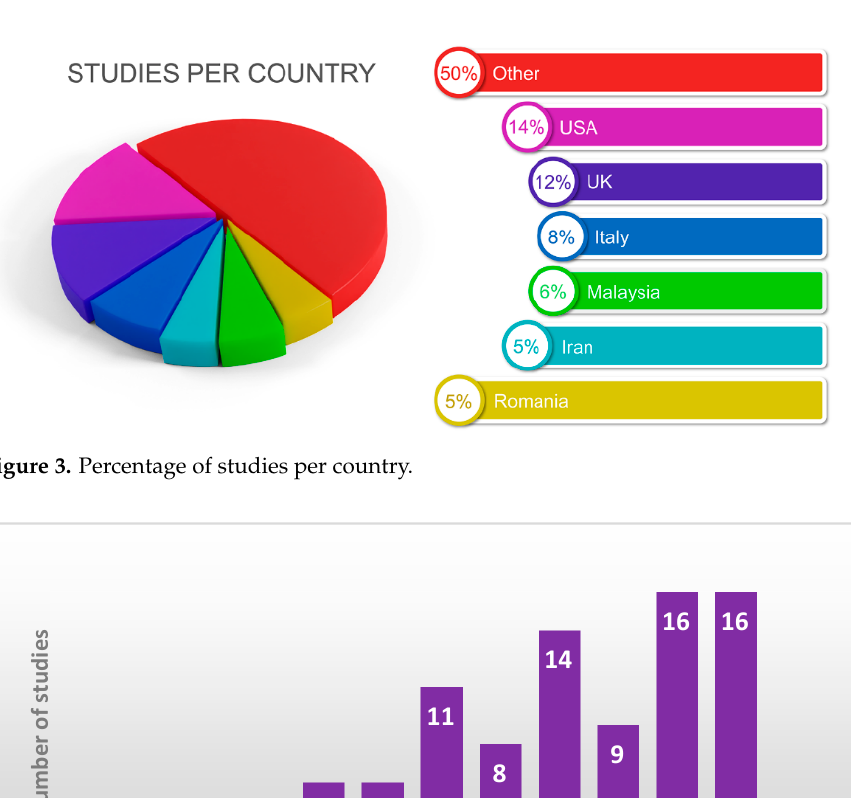
Figure 3. Percentage of studies per country.